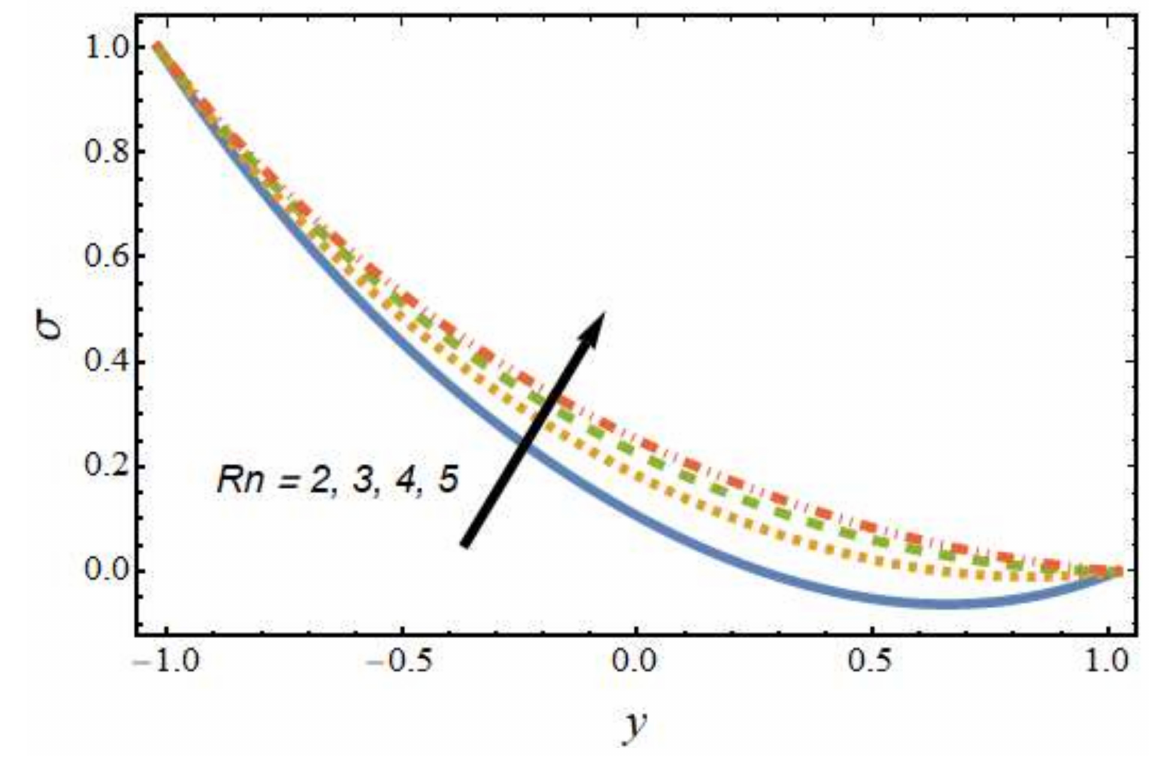
Figure 12. Nanoparticle concentration profile for various values of the radiation parameter.